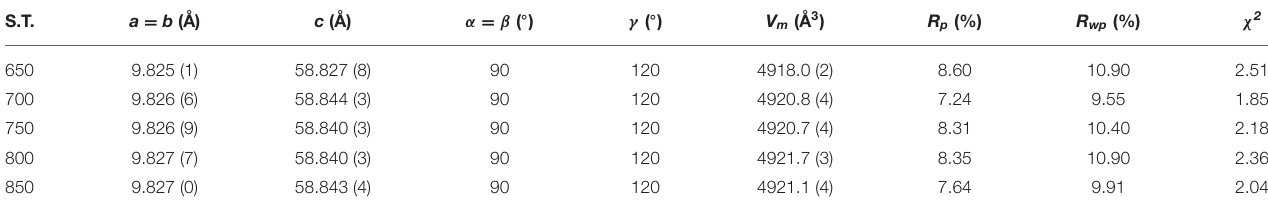
TABLE 1 | The refinement parameters, theoretical densities and relative densities of Ce 2 (Zr 0.94 Sn 0.06 ) 3 (MoO 4 ) 9 ceramics fired at 650–800 ◦ C. S.T.